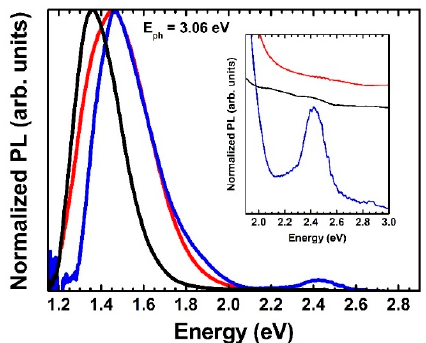
Figure 3. Static PL normalized spectra of the as grown (AG, black curve), 5000× g centrifuged (5k, blue curve) and 5000× g and annealed in forming gas at 800 °C (5k@, red curve). The inset is a zoom of the 1.9–2.9 eV spectral region.